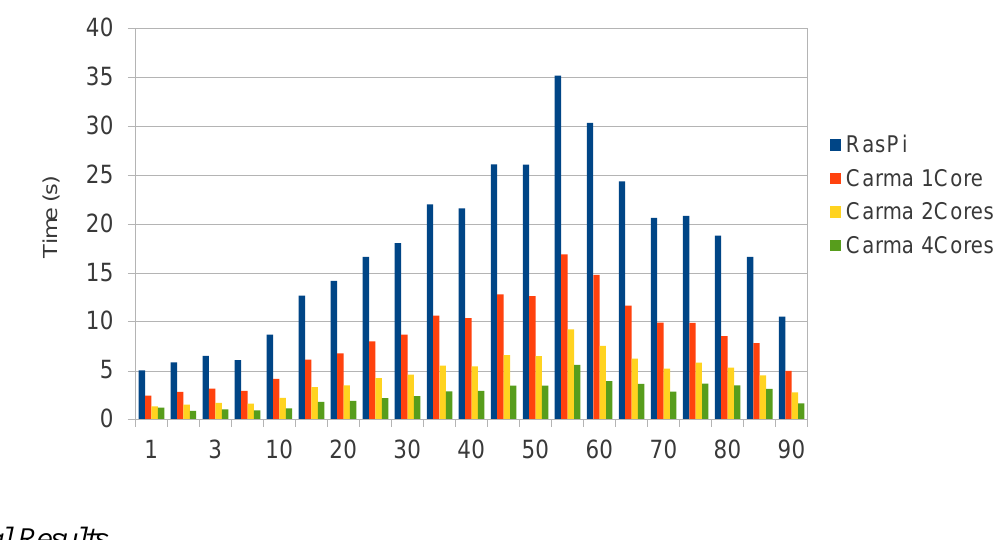
Figure 23. Summary of sensor times using different approaches (Raspberry-Pi and Carma